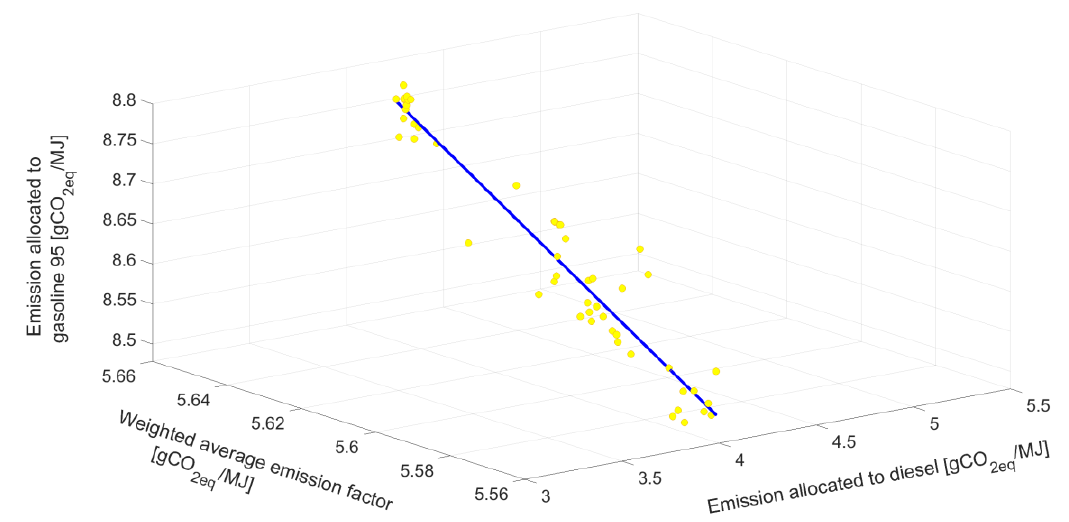
Figure 11. Weighted average GHG emissions of motor fuels versus emissions allocated to diesel and gasoline 95 for the selected set of results.